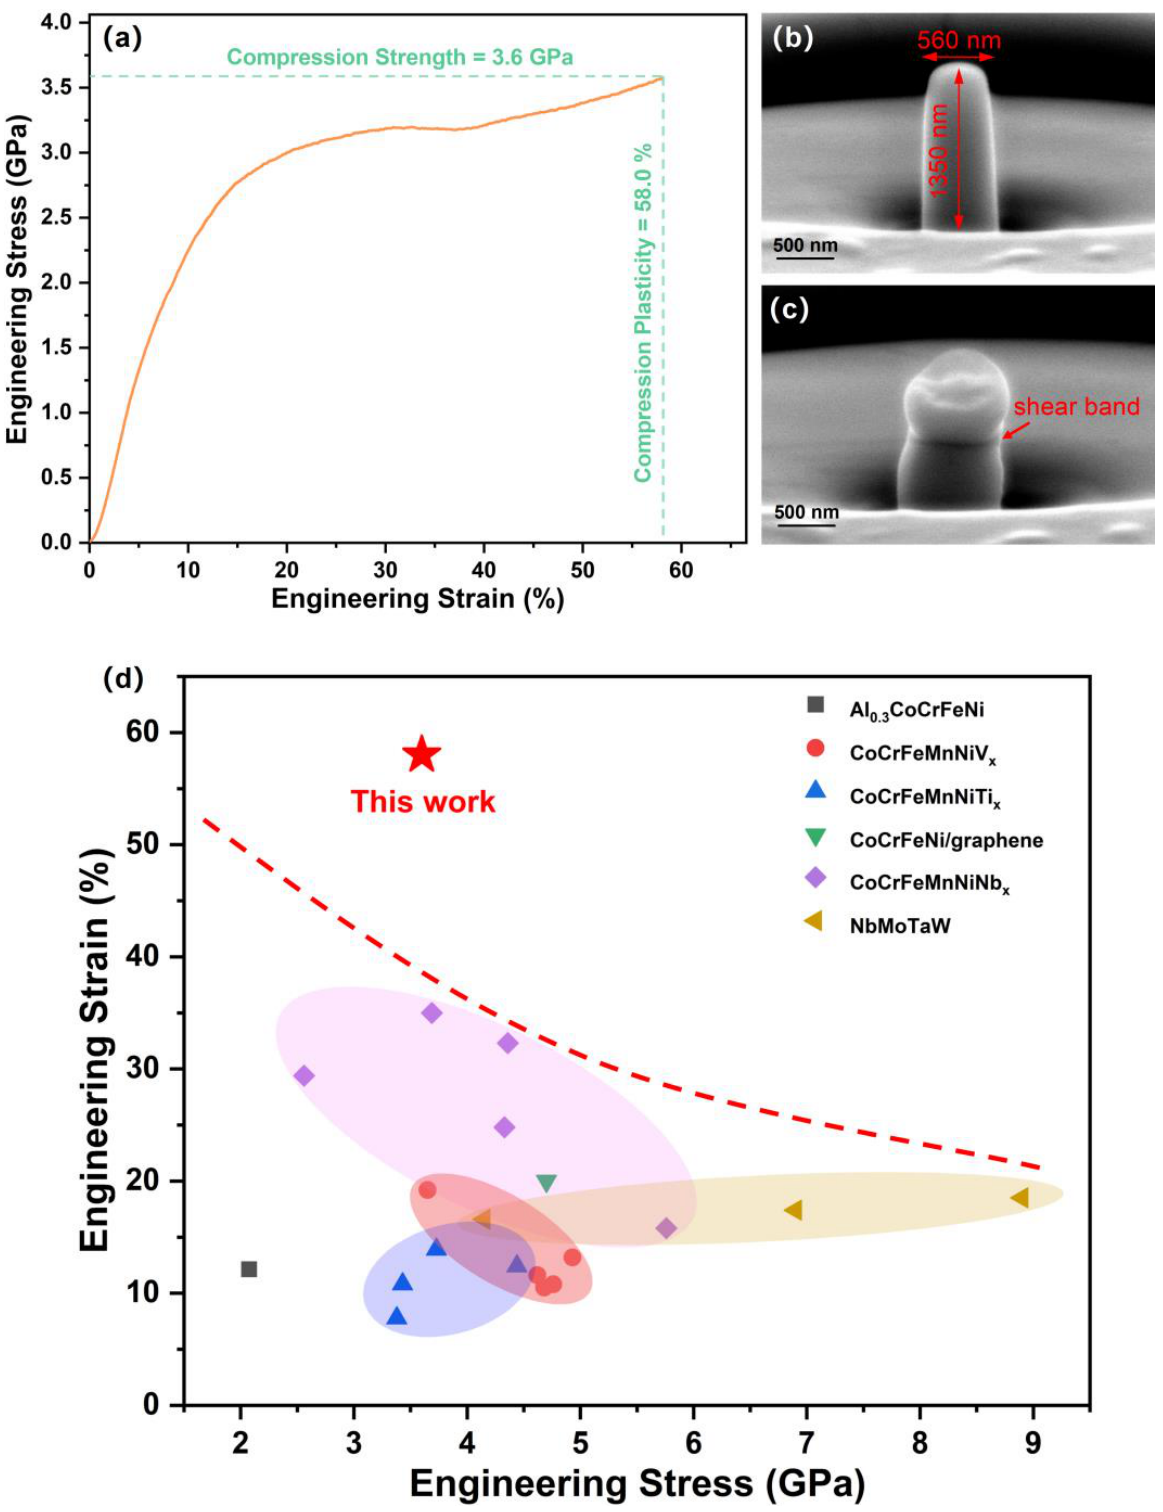
Figure 3. ( a ) The compressive engineering stress – strain curve of the AlTiVCr HEA film; The corre- sponding morphologies of HEA film pillars before ( b ) and after ( c ) compression; ( d ) The engineering strain and stress of the AlTiVCr HEA film pillar compared with other HEA pillars with similar scales in diameter.